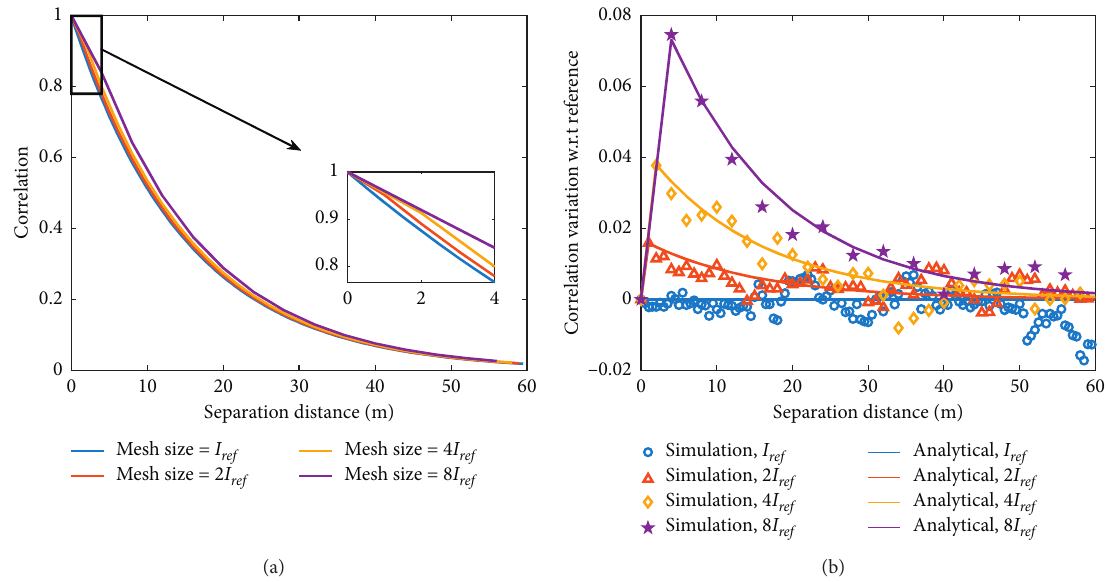
Figure 9: The correlation of material properties at different locations: (a) correlation vs. separation distance based on analytical for- mulations and (b) the change of correlation at a coarse scale with respect to the correlation at the reference scale based on the analytical formulations and the simulated random